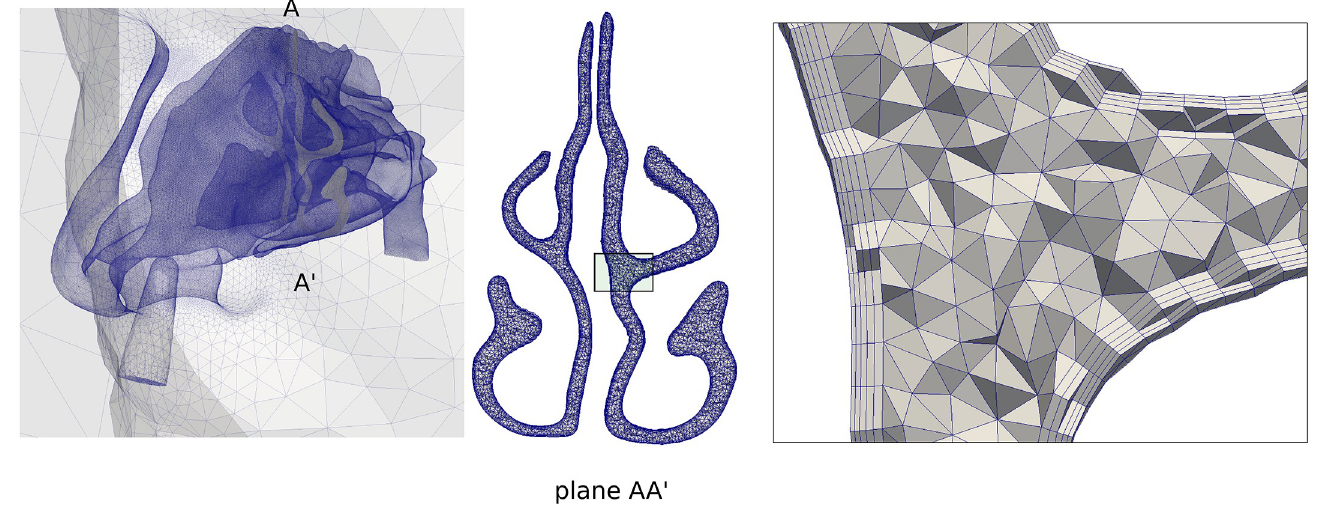
Fig 2. Grid generation topology for M2. Plane AA’ is the same as plane B, see Fig 1.